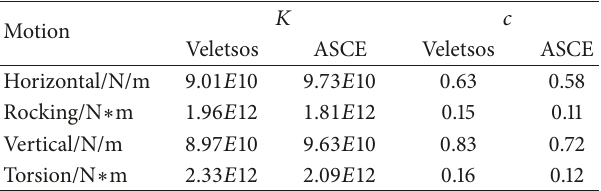
Table 4: Calculation results comparison between two methods.